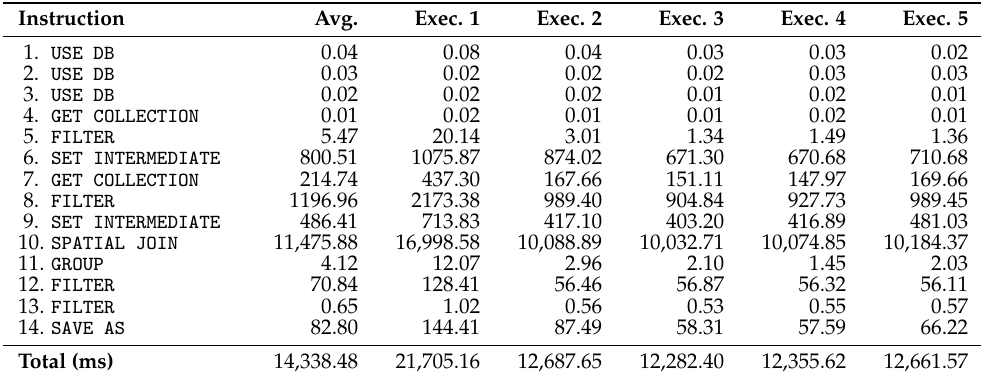
Table 4. Execution times (in ms) for data set DS_10 on one single process of the J-CO-QL Engine .